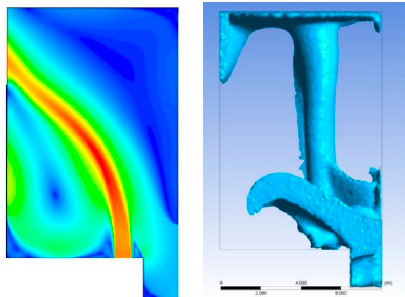
Figure 5. Comparison of 2D ( Left ) and 3D ( Right ) flow pattern.